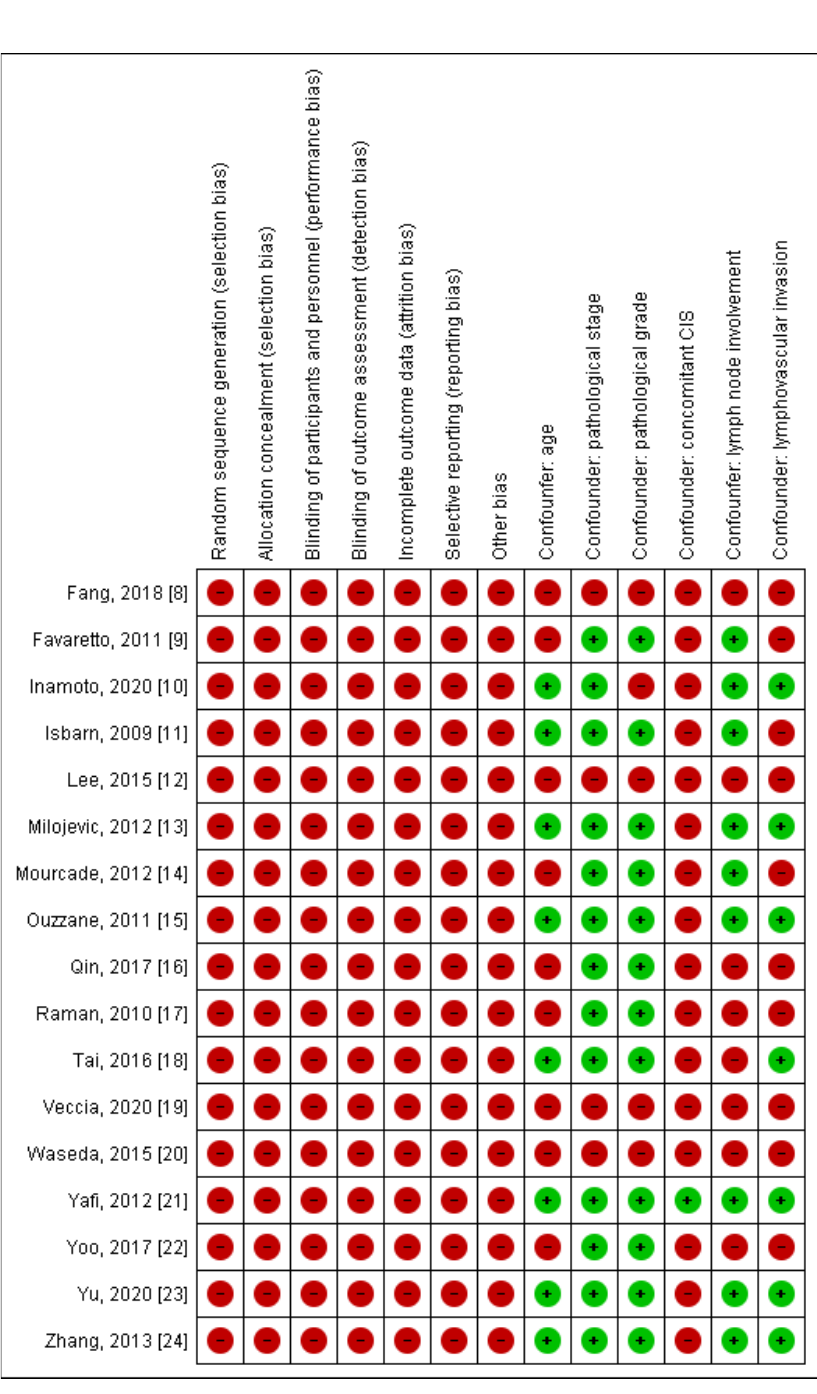
Figure 2. The risk of bias (RoB) and confounding assessment for all included studies [8–24]. CIS = carcinoma in situ.